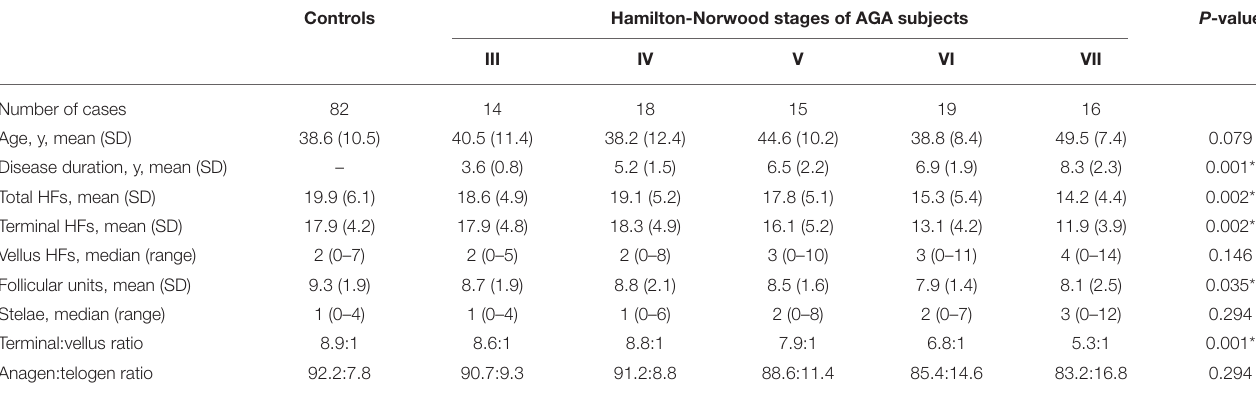
TABLE 2 | Hair counts in the occipital scalp of controls and patient subgroups with different disease severity of androgenetic alopecia.